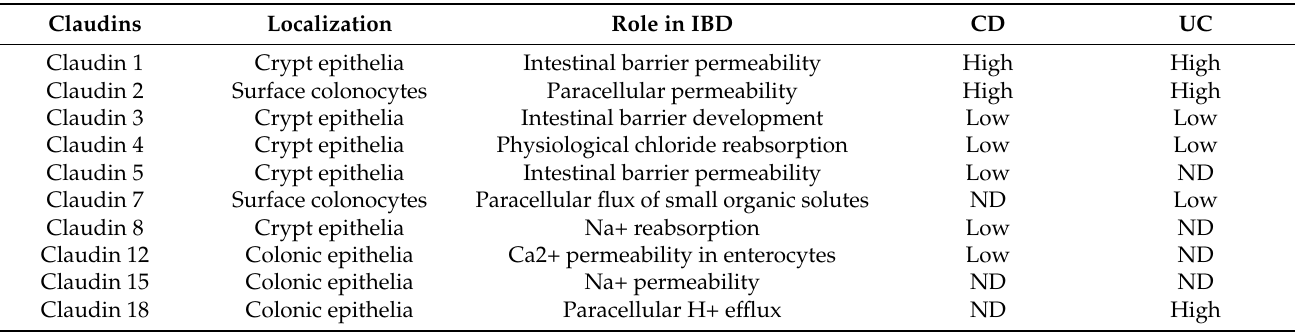
Table 1. Expression modulations of claudins in the pathogenesis of